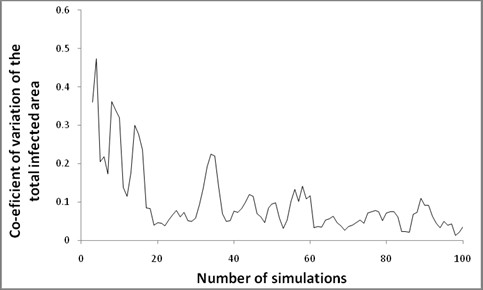
Number of simulations plotted against coefficient of variation of the total infected area. Approximate consistency (coefficient of variation < 15%) was achieved at 59 simulations.